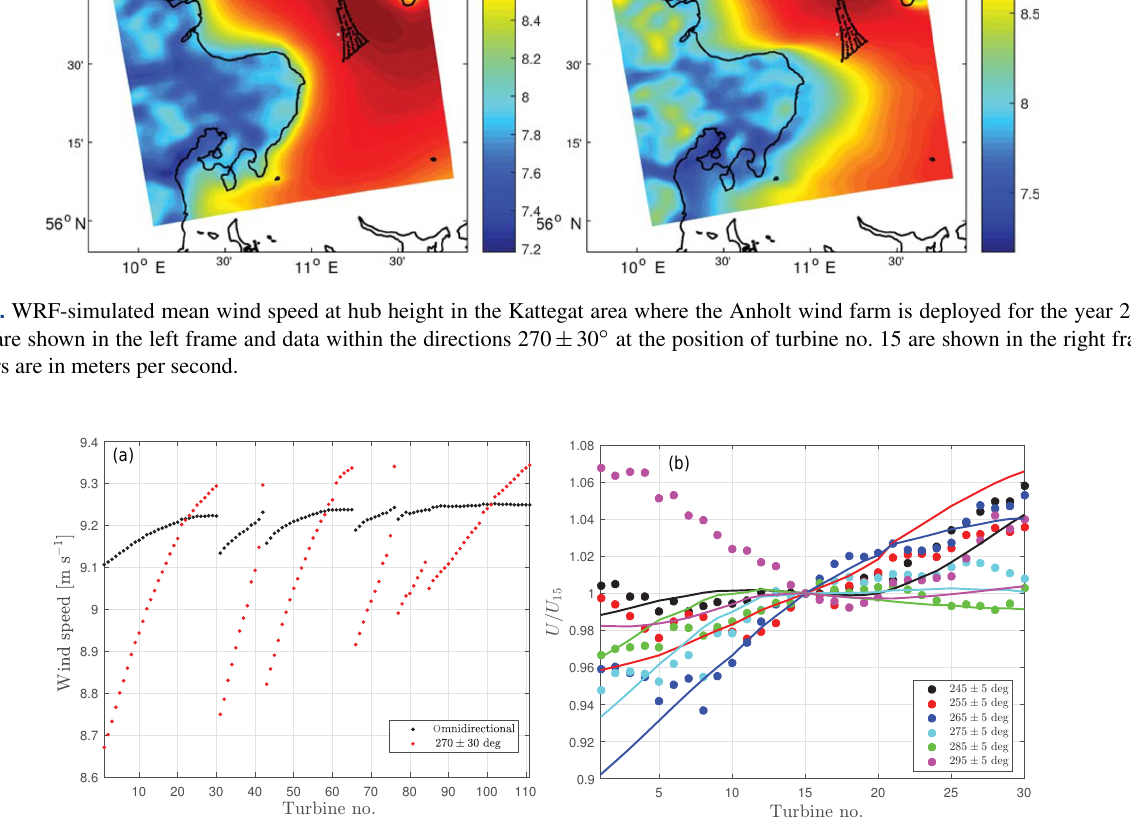
Table 2. Difference (in percentage) between different type of AEP calculations and that using the horizontal wind-speed gradient information from the WRF simulations